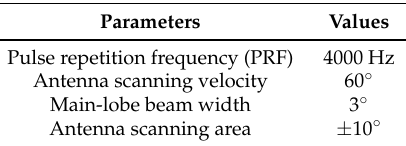
Figure 2. Simulation experiment ( a ) simulated scene; ( b ) echo. Table 2. Simulation